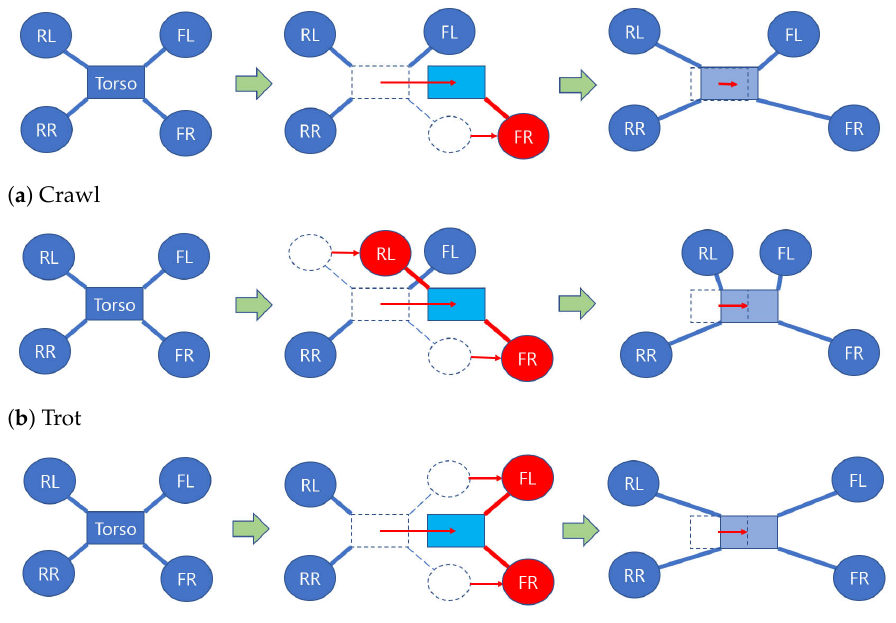
Figure 12. Foot and torso target position generation for various gait patterns.